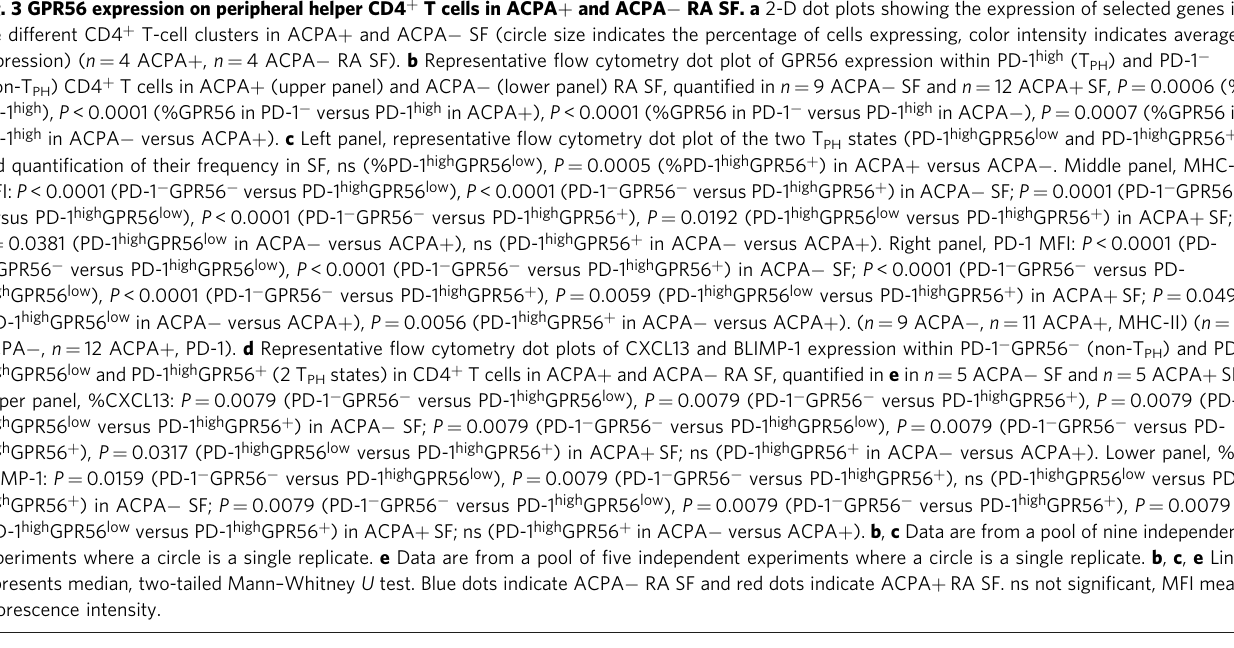
Fig. 3 GPR56 expression on peripheral helper CD4 + T cells in ACPA + and ACPA − RA SF. a 2-D dot plots showing the expression of selected genes in the different CD4 + T-cell clusters in ACPA + and ACPA − SF (circle size indicates the percentage of cells expressing, color intensity indicates average expression) ( n = 4 ACPA + , n = 4 ACPA − RA SF). b Representative fl ow cytometry dot plot of GPR56 expression within PD-1 high (T PH ) and PD-1 − (non-T PH ) CD4 + T cells in ACPA + (upper panel) and ACPA − (lower panel) RA SF, quanti fi ed in n = 9 ACPA − SF and n = 12 ACPA + SF, P = 0.0006 (% PD-1 high ), P < 0.0001 (%GPR56 in PD-1 − versus PD-1 high in ACPA + ), P < 0.0001 (%GPR56 in PD-1 − versus PD-1 high in ACPA − ), P = 0.0007 (%GPR56 in PD-1 high in ACPA − versus ACPA + ). c Left panel, representative fl ow cytometry dot plot of the two T PH states (PD-1 high GPR56 low and PD-1 high GPR56 + ) and quanti fi cation of their frequency in SF, ns (%PD-1 high GPR56 low ), P = 0.0005 (%PD-1 high GPR56 + ) in ACPA + versus ACPA − . Middle panel,